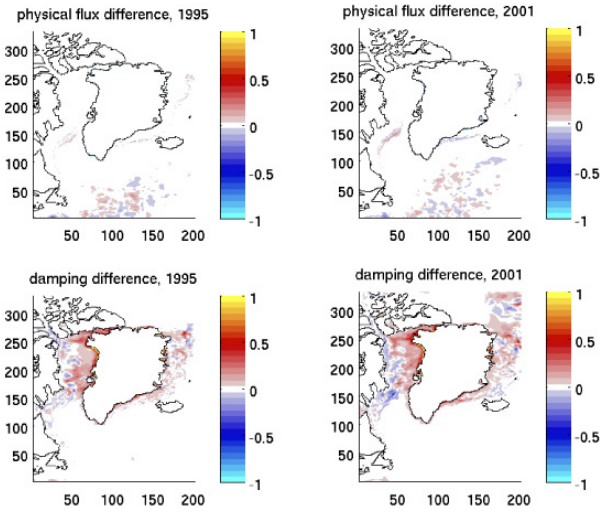
Fig. 13. Differences (sensitivity minus control) for 1995 and 2001 in the two components of annual-mean net upward water flux: phys- ical surface water flux (upper panels), and the damping term (lower panels). Units are 10 − 4 kgm − 2 s − 1 )